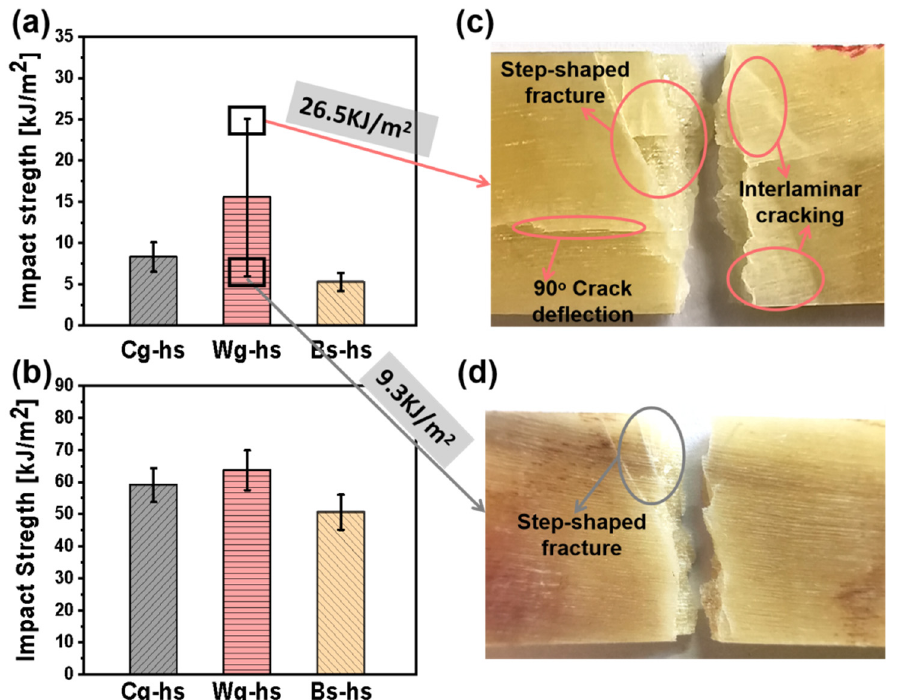
Figure 2. Impact property of three different Caprinae horn sheaths. ( a ) Bar chart of impact strength of dried specimens; ( b ) Bar chart of impact strength of hydrated specimens; ( c ) Fracture photograph of the dried Wg-hs sample with high impact strength; ( d ) Fracture photograph of the dried Wg-hs sample with lowest impact strength.